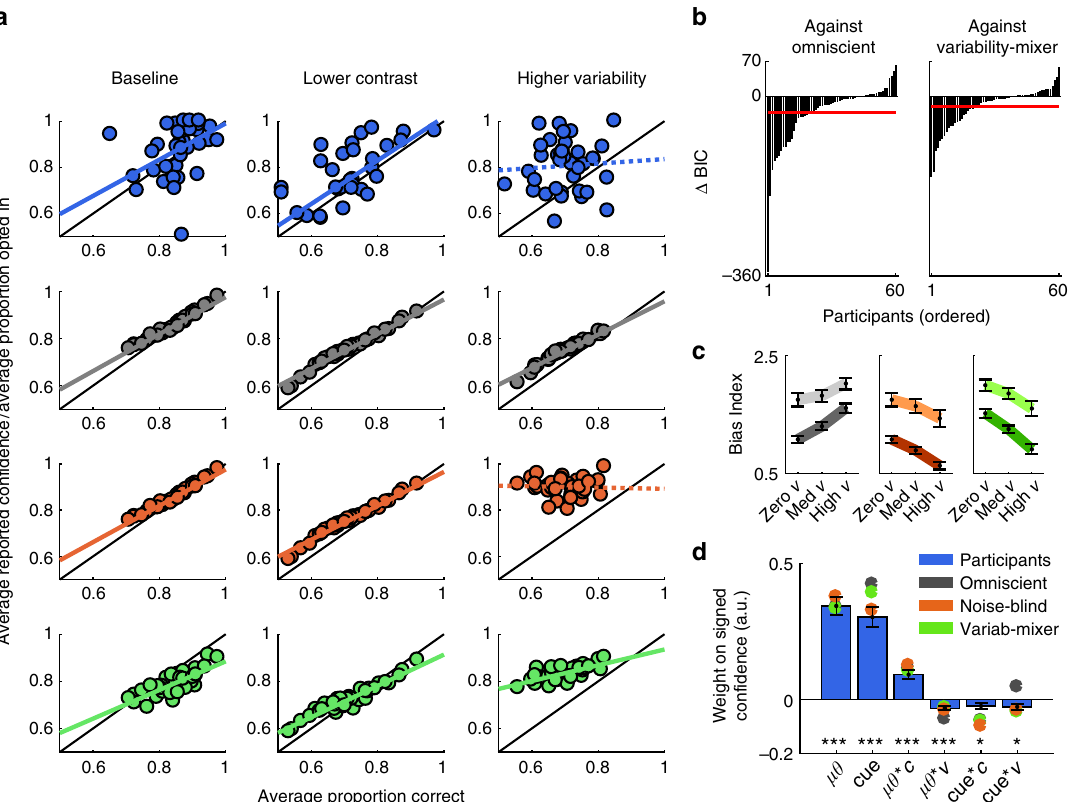
Fig. 5 Comparison of model and human behaviour. a Correspondence between mean accuracy and mean con fi dence (explicit or implicit) for participants (blue, data from Exp2 – 3) and the omniscient (grey), noise-blind (orange), and variability-mixer (green) models in the critical experimental conditions. Coloured lines indicate best- fi tting slope of a linear regression analysis: solid for p < 0.01, dashed for p > 0.2. b Model comparison (Exp1 – 3) suggests strong evidence in favour of the noise-blind model over the omniscient model (left panel, average Δ BIC = − 32.9) and also over the variability-mixer model (right panel, Δ BIC = − 20.4). c Omniscient model (left) makes opposite predictions to noise-blind model (middle) and variability-mixer model (right) for the in fl uence of the prior cue on choice (Exp1 – 2) as variability increases (positive versus negative slopes) but similar predictions as contrast decreases (lighter lines above darker ones). Dark colours: high contrast. Light colours: low contrast. d Trial-by-trial analysis of signed con fi dence (Exp2; negative for CCW and positive for CW) for participants (blue) and the omniscient (grey), noise-blind (orange), and variability-mixer (green) models. a – d For panel a , only neutral and optional trials were used. For panels b and c , only biased trials were used. For panel d , both neutral and biased trials were used. Within-model variability in predictions comes from variability in encoding and integration noise across participants. For panels c and d , data are represented as group mean ±